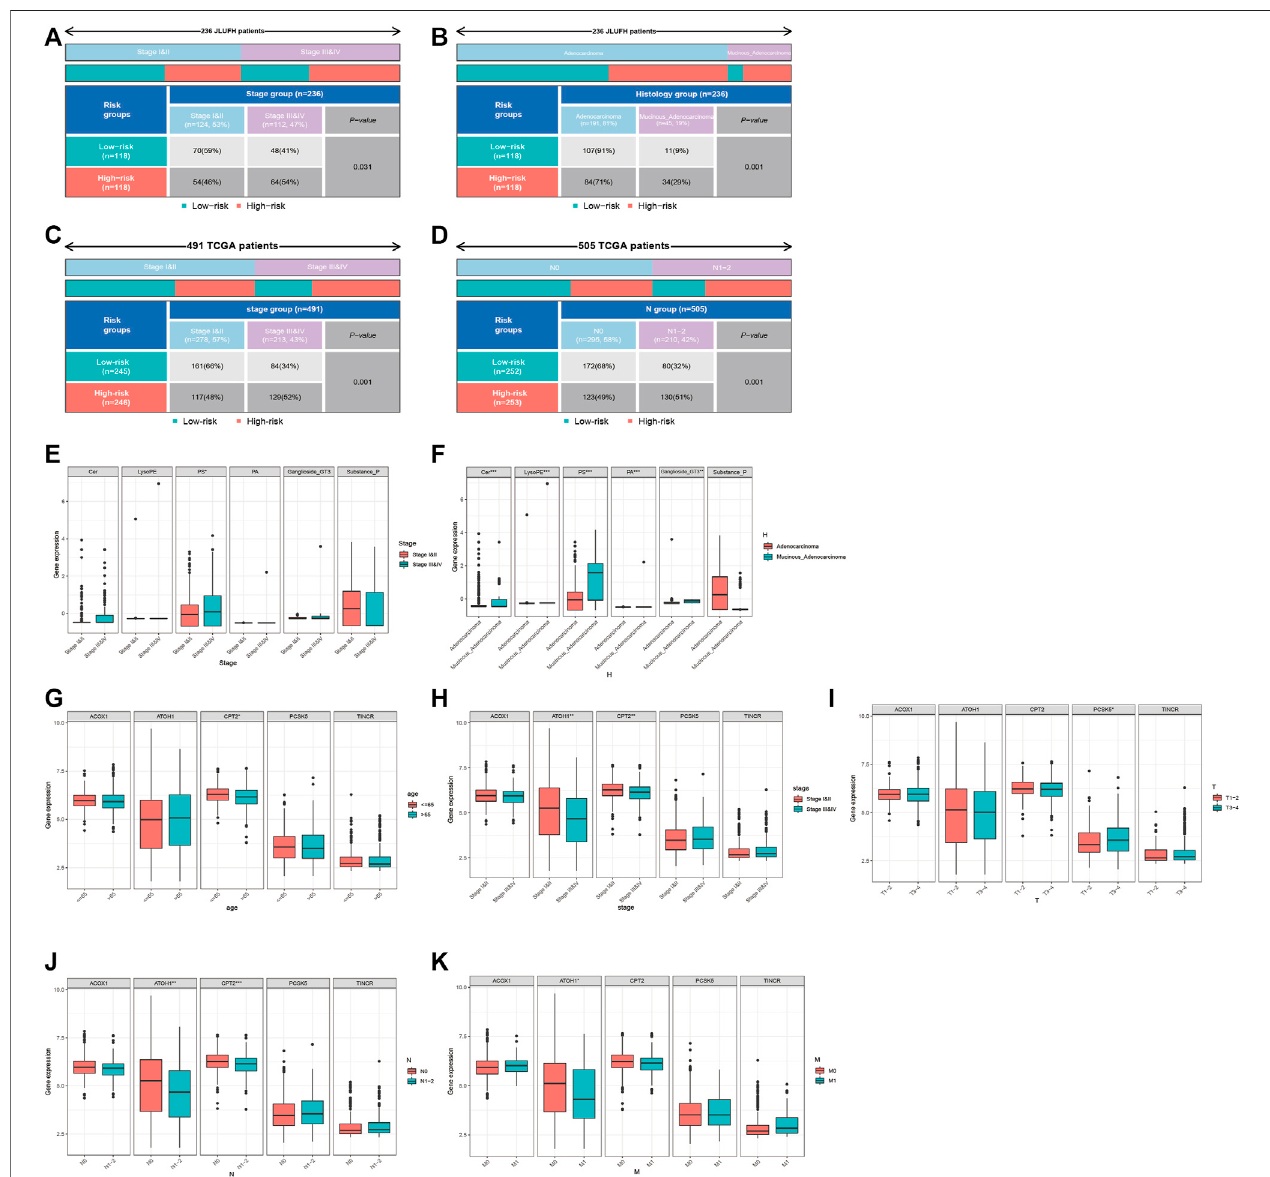
FIGURE 7 | Clinical correlation analysis for the JLUFH and TCGA CRC patients. (A,B) : The distributions of pathological stage and histological type of JLUFH CRC patientsinthehigh-andlow-riskgroups. (C,D) :ThedistributionsofpathologicalstageandNstagingofJLUFHCRCpatientsinthehigh-andlow-riskgroups. (E,F) :The differences of the levels of six lipid metabolites in the JLUFH CRC patients with stage I and II, stage III and IV and adenocarcinoma, and mucinous adenocarcinoma. (G – K) : The differences of the levels of fi ve GMRHGs in the TCGA CRC patients with various clinical characteristics (age, pathological stage, T staging, N staging, and M